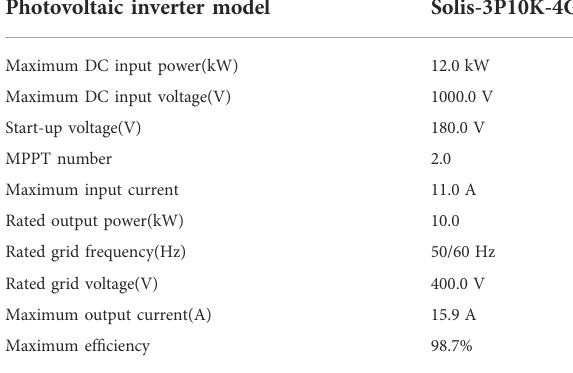
TABLE 4 Solis three-phase inverter detail speci fi